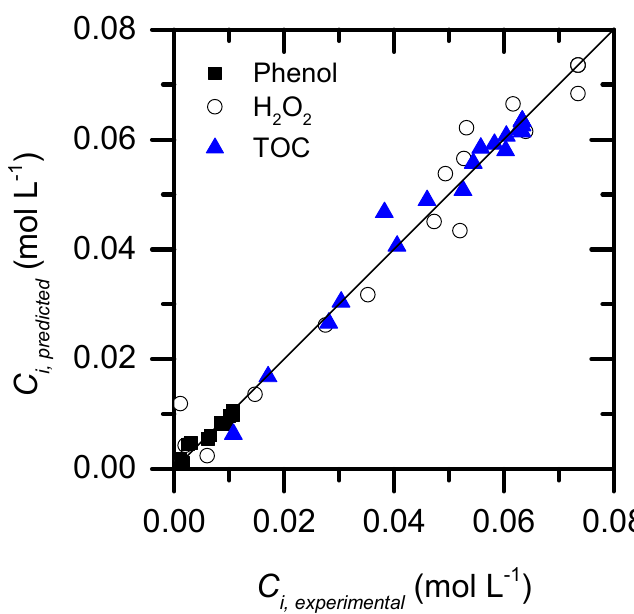
Figure 7. Parity plot for phenol, H 2 O 2 and TOC evolution upon WPO-O 2 of phenol over quartz beads within the temperature range 100 – 140 ºC using the autocatalytic kinetic model. Operating conditions: